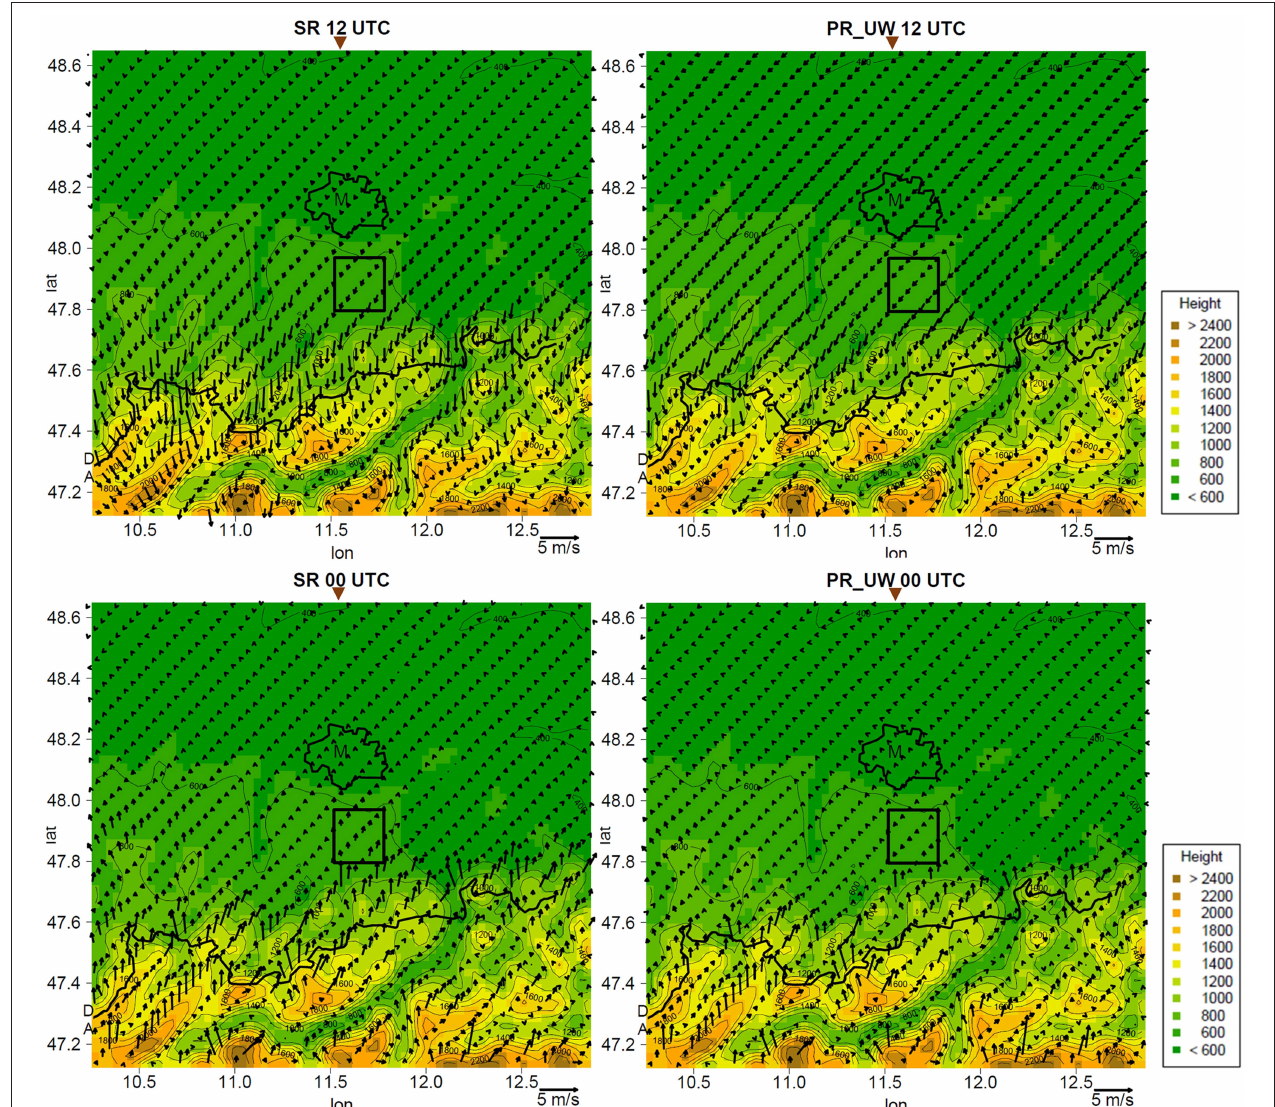
FIGURE 5 | Averaged surface wind maps of the horizontal wind vector at 10m agl for SR criterion (left) and PR_UW criteria combination (right) at 12 UTC (top) and 00 UTC (bottom). Bold black lines show the urban area of Munich (indicated by the letter M) and the German-Austrian border, while thin black contour lines represent the terrain height. 8 × 8 model grid points within the black rectangular frame (south of Munich) are used to calculate the wind oscillation criterion. The triangles at the top of the panels indicate the geographical longitude of the meridional cross sections shown in Figure 7 .